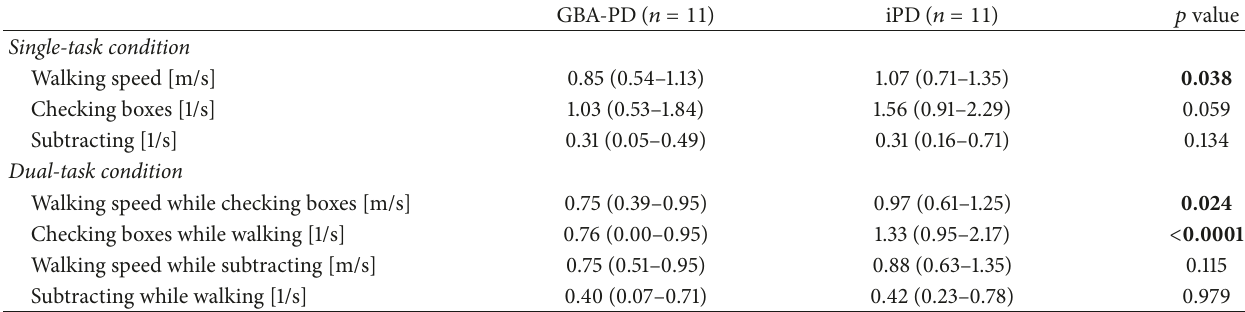
Table 2: Single- and dual-task performance.